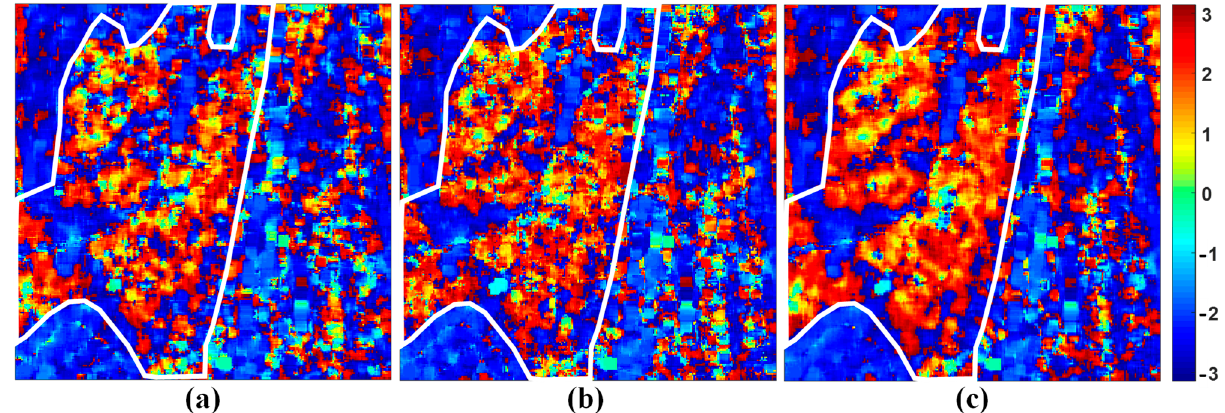
Figure 10. Optimized interferograms between the 9th and 1st acquisitions of ROI (250 × 250 pixels) using ( a ) HH, ( b ) ESPO, and ( c ) proposed TSTP methods. The lowly coherent natural area is marked by the white irregular box in Figure 10a–c.